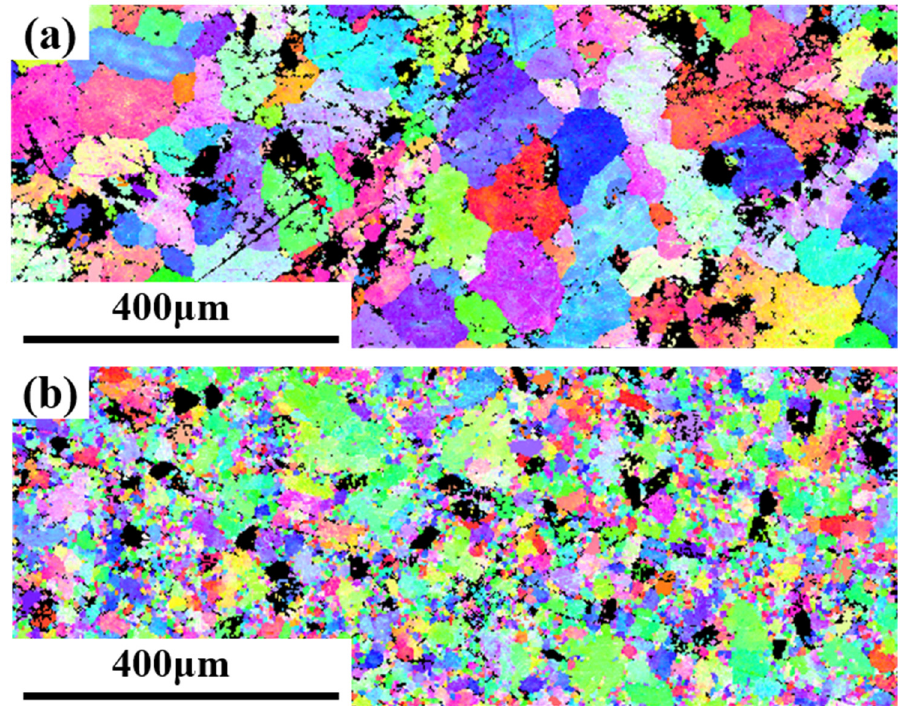
Figure 4. Results of the electron backscatter diffraction (EBSD) analysis of 9 vol.% SiC/AA2024: ( a ) stir-casting (SC) process, ( b ) die-casting (DC)